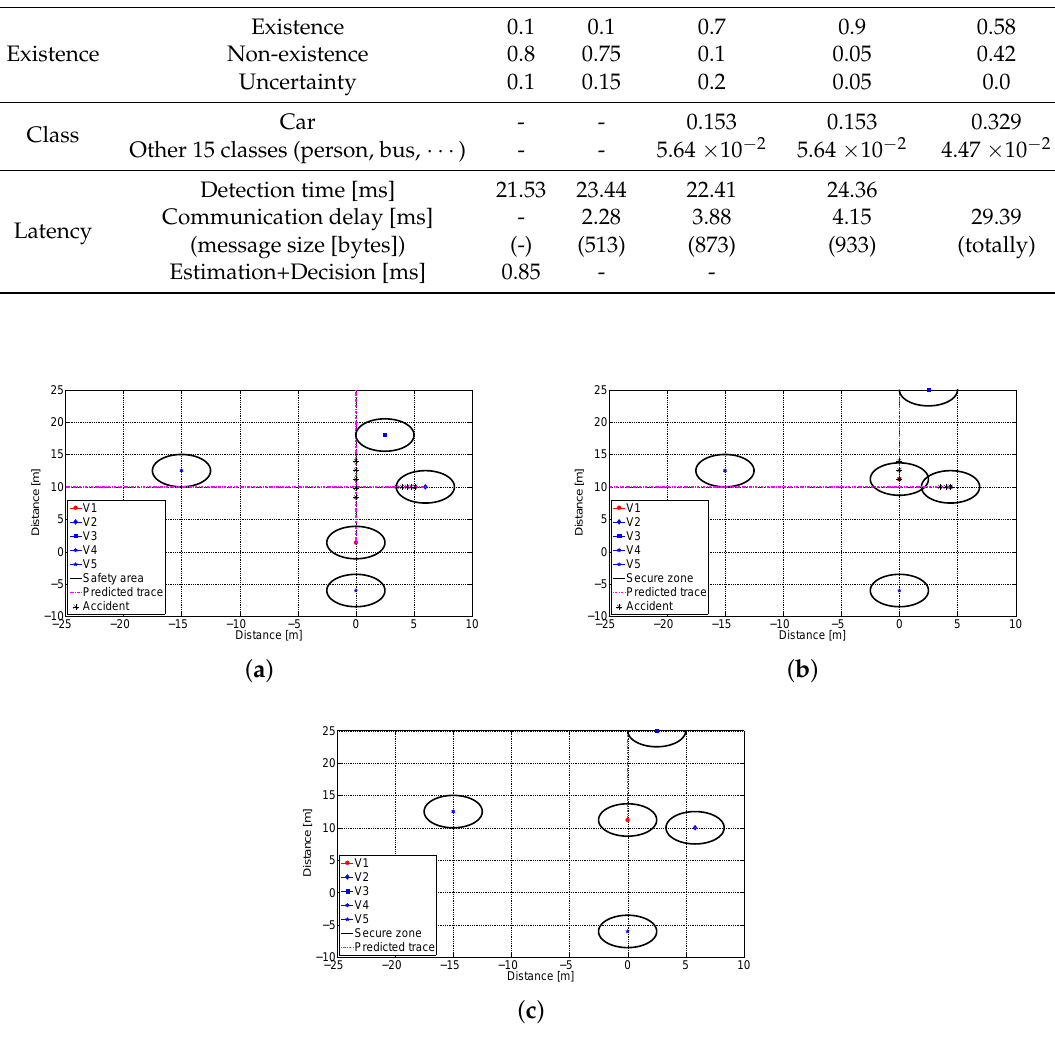
Figure 17. Environment modeling: ( a ) Traces at t = 0 s. ( b ) Traces at t = 0.7 s without the anti-collision system. ( c ) Traces at t = 0.7 s with the proposed